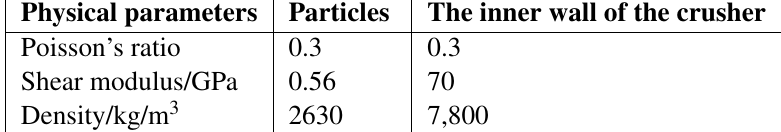
Table 1 The physical parameters of particles and the inner wall of the crusher